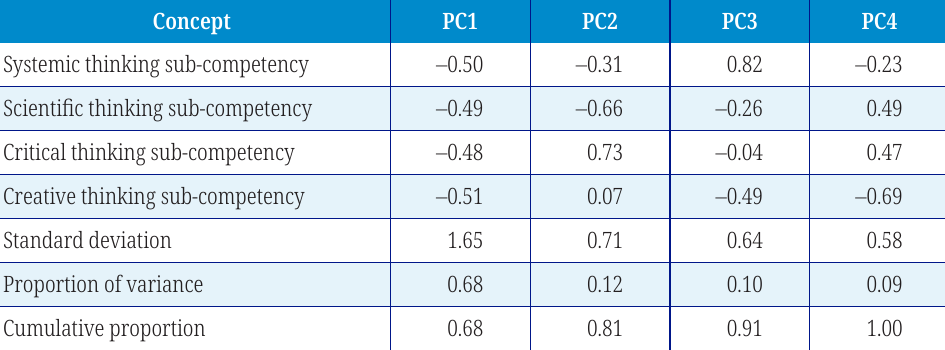
Table 4. Complex thinking: principle components matrix